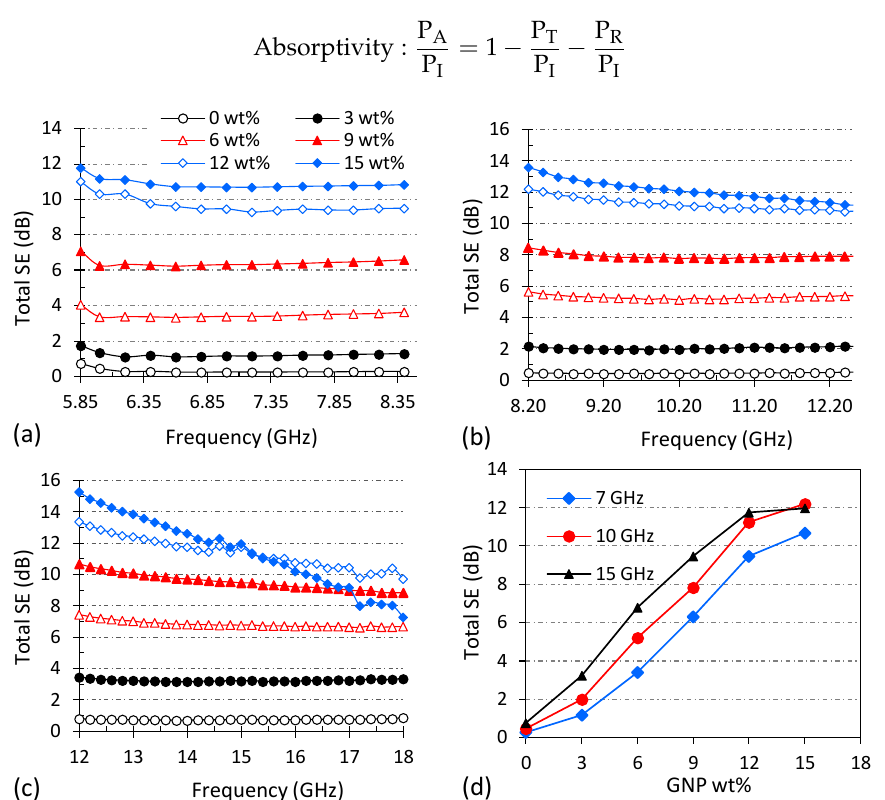
Figure 5. EMI shielding effectiveness of PBAT/GNP nanocomposites over ( a ) C-band, ( b ) X-band, ( c ) Ku-band, and ( d ) as a function of GNP loading at mid-range frequencies.